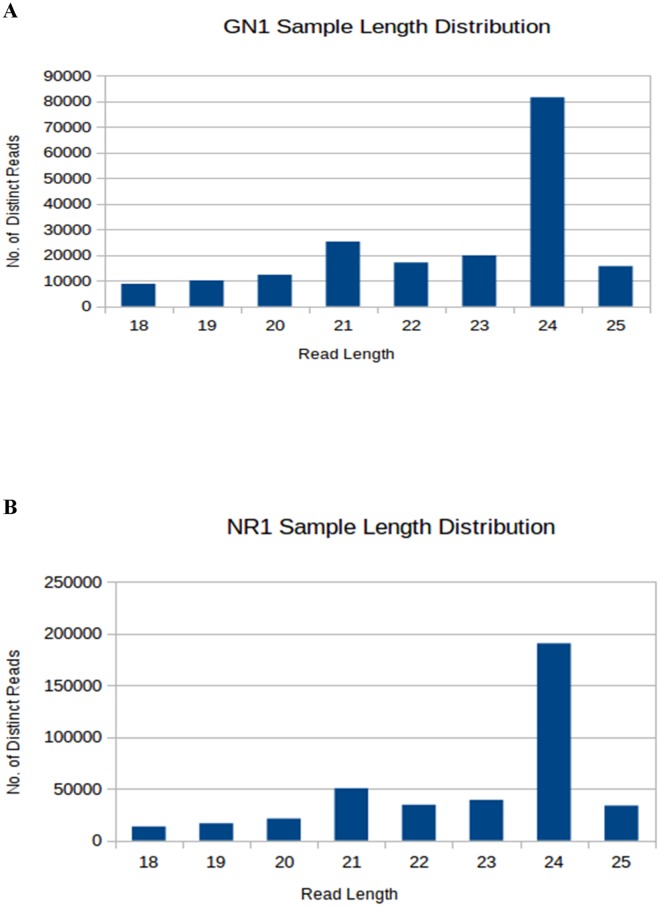
Size distribution of small RNA sequences.Sequence reads and unique sequence distribution showing the predominance of the 24 and 21nt length reads in Grand Naine (A) and Rasthali (B) small RNA libraries.